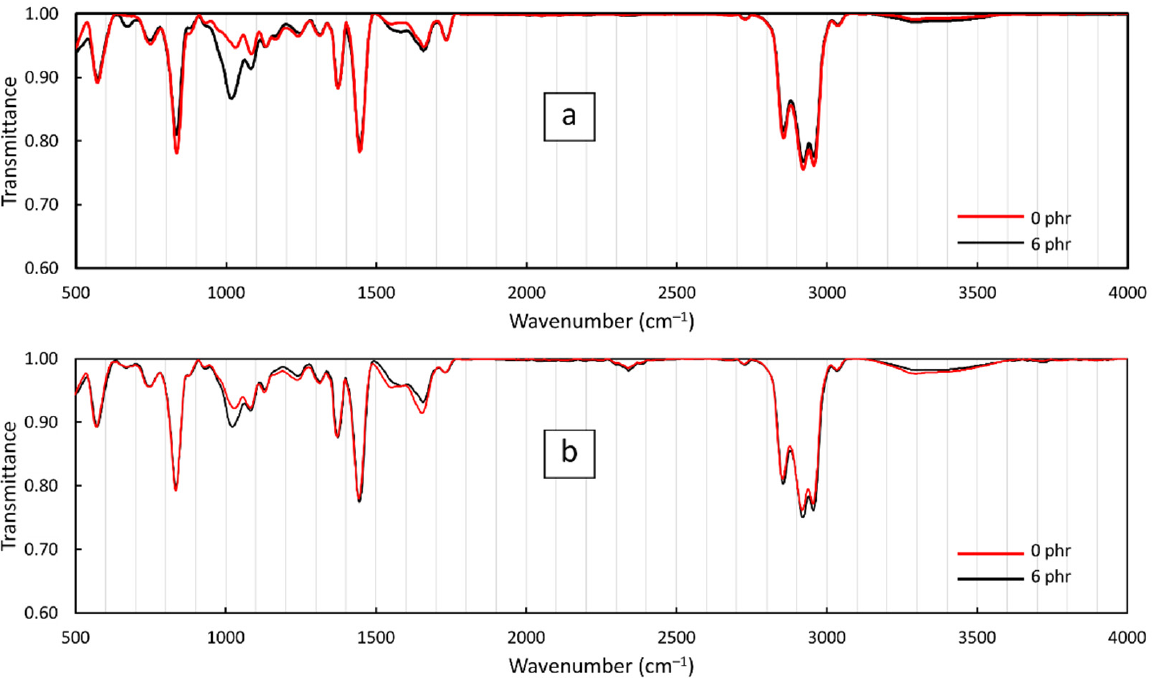
Figure 3. IR spectra of ( a ) pristine R-VNRL and 6-phr CS/R-VNRL composites and ( b ) pristine RP-VNRL and 6-phr CS/RP-VNRL composites.